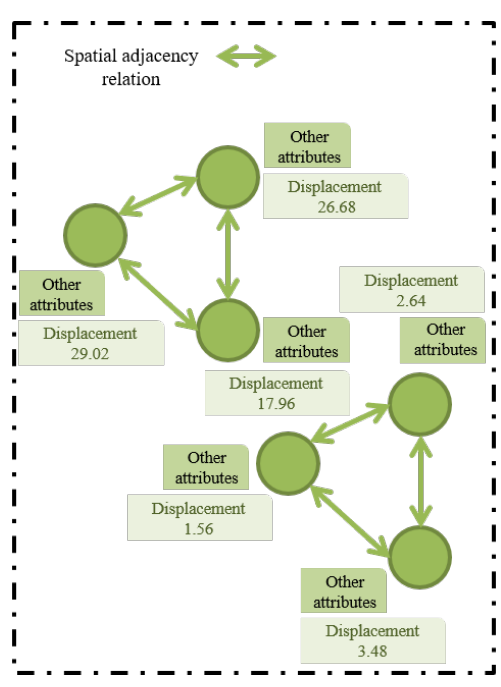
Figure 1. The structure of a knowledge graph at time τ